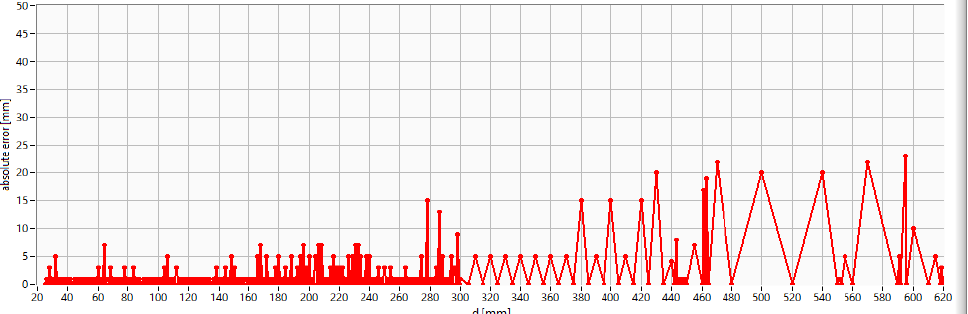
Figure 7. Sharpness cost function for the current measurement (d = 104 mm).